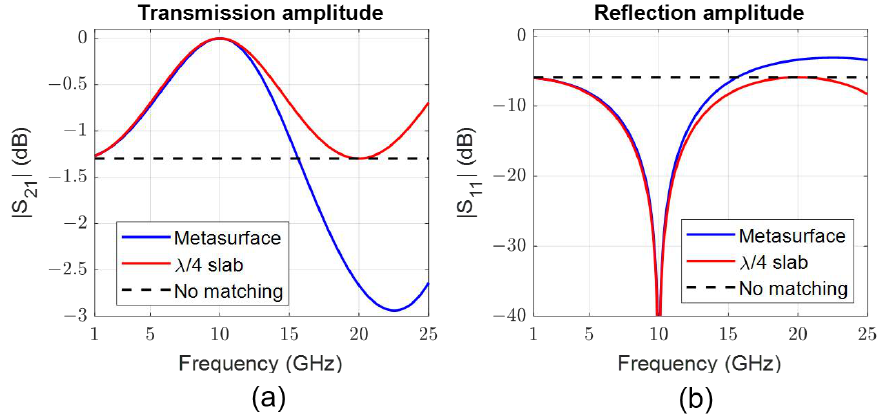
Figure 6. Plots of the ( a ) transmission and ( b ) reflection magnitudes for the interface with the metasurface ( φ 21 = − 68.5 ◦ ), a quarter-wave transformer, and with no impedance matching (bare interface). The simulations of the metasurface were performed in Ansys HFSS. The metasurface has a bandwidth that is comparable to a quarter-wave